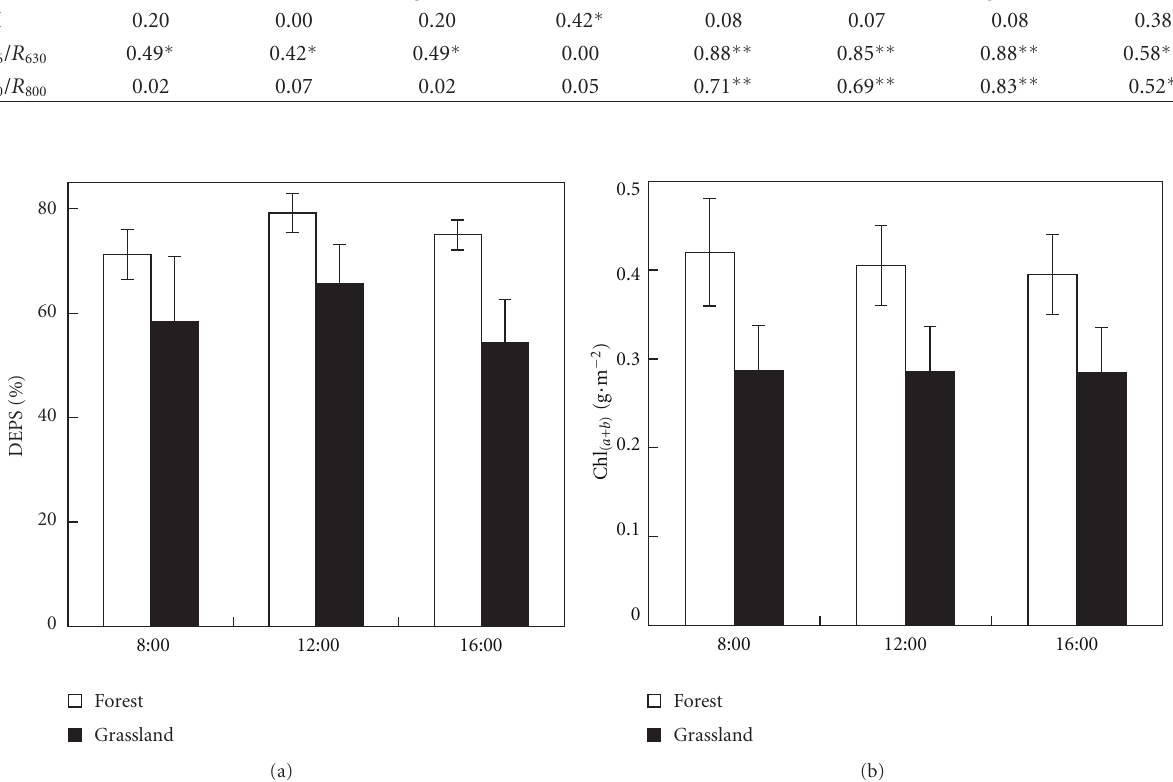
Figure 3: Diurnal courses of the deepoxidation state of xanthophyll cycle pigments DEPS = (Z + A)/(V + A + Z), where Z is zeaxanthin, A is antheraxanthin, and V is violaxanthin (a) and total chlorophyll pigment content (Chl ( a + b ) ) (b) of grassland and forest ecosystem (black and white columns, resp.). DEPS values represent a mean value of current, 1-year-, and 2-year-old needles ( n = 24), and Chl ( a + b ) values represent the mean values of current needles ( n = 6). Error bars indicate standard